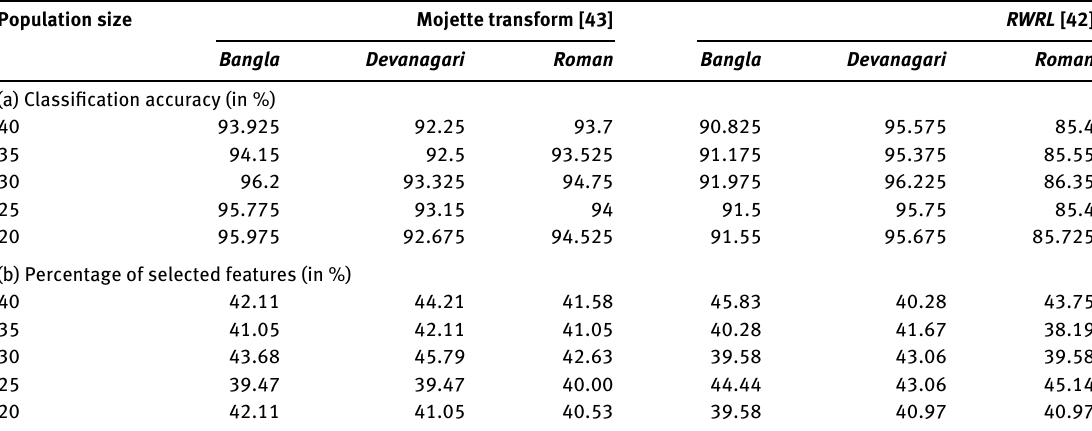
Table 2: Effect of Change in Population Size with (a) Classification Accuracy of Selected Features and (b) Percentage of Features Selected in E1.